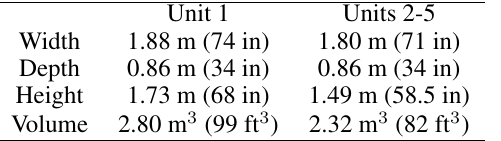
Table 1. Interior dimensions of environmental